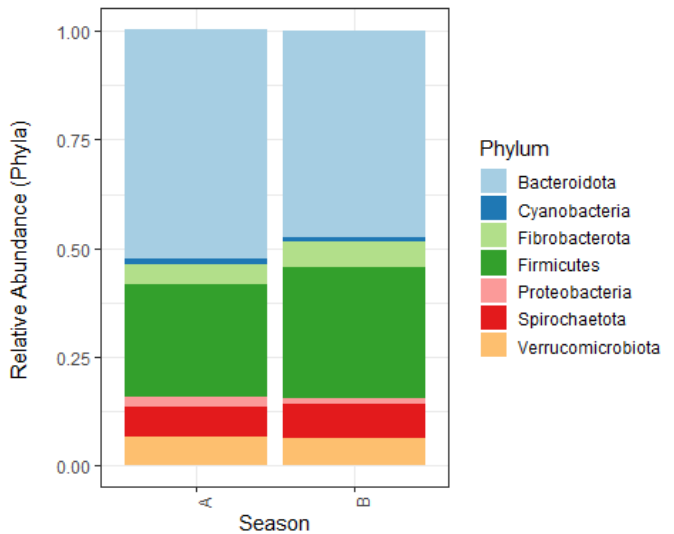
Figure 5. Relative abundance of phyla in the faecal microbiota of 61 horses and ponies in the Neth- erlands. ( A ) Summer ( B ) Winter.